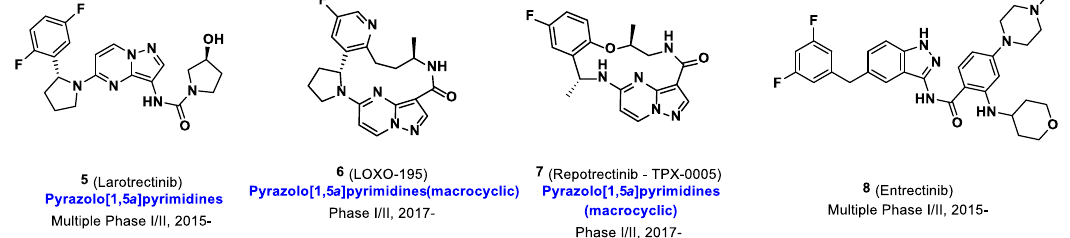
Figure 4. Chemical structures of selected clinical Trk inhibitors.